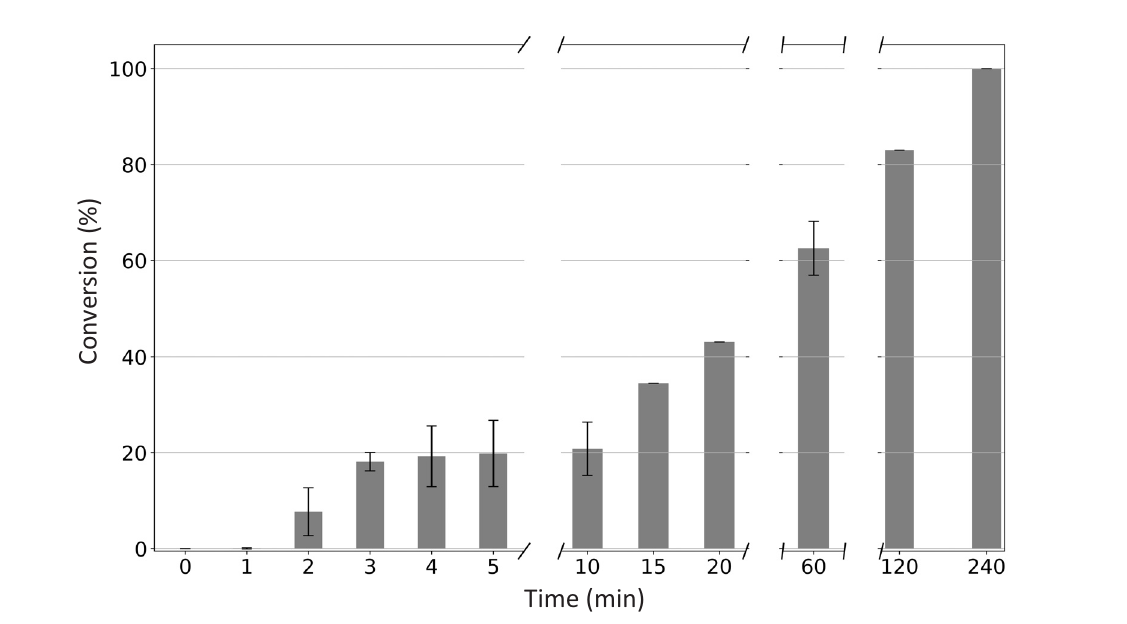
Fig. 3. Acetanilide bromination in the reaction mixture, containing 5.5 mmol KNO 3 and 5 mmol acetanilide, and at constant HBr flow (normal pressure). The error bars were calculated from triplicate experiments, while conversion values at 15, 20 and 120 min were calculated from single experiments.